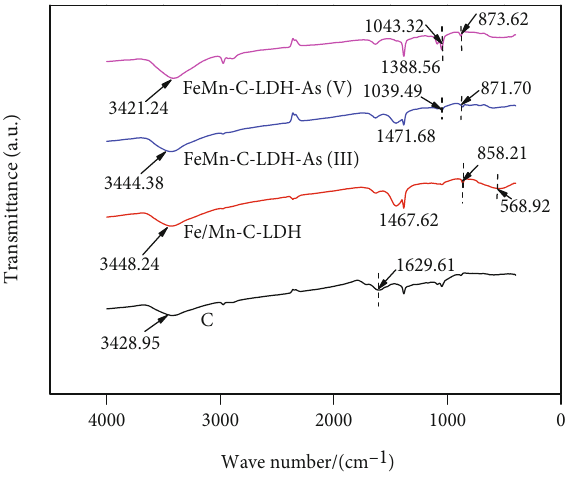
Figure 4: The FTIR of C and Fe/Mn-C-LDH with As adsorption.